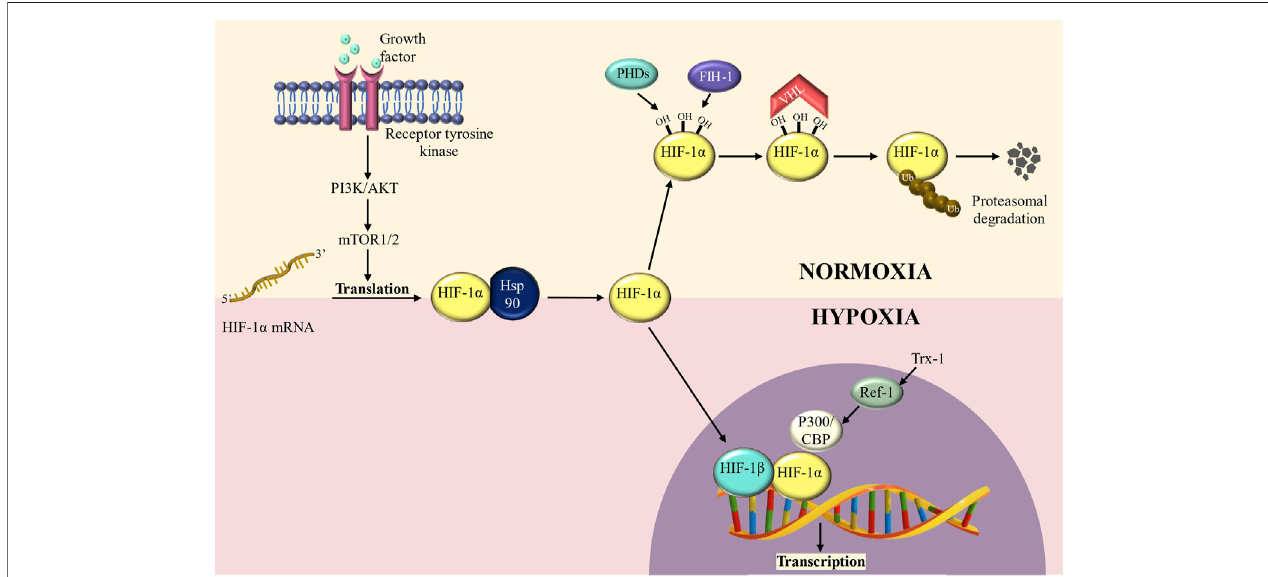
FIGURE1| HIF-1 α regulationinnormoxicandhypoxicconditions.HIF-1 α ishydroxylatedatconservedresidue(Proline564 ) undernormoxicconditions,aprocess mediated by prolyl-4- hydroxylases (PHDs) and factor inhibiting HIF-1 (FIH-1) enzymes. PHD hydroxylation promotes HIF-1 α protein destabilization, whereas FIH-1 hydroxylation inhibits transcriptional activity by preventing interaction with CBP/p300. HIF-degradation is mediated by a ubiquitin-dependent process carried out by the Von Hippel-Lindau (VHL) E3 ubiquitin ligase complex. Under hypoxic circumstances, inactivation of PHDs and FIH-1 causes HIF-stabilization, followed by translocation into the nucleus and dimerization with HIF-1/ARNT to create the HIF transcription factor. During hypoxia, HIFs, in collaboration with the coactivator CBP/ p300, promote transcription of a wide range of target genes.